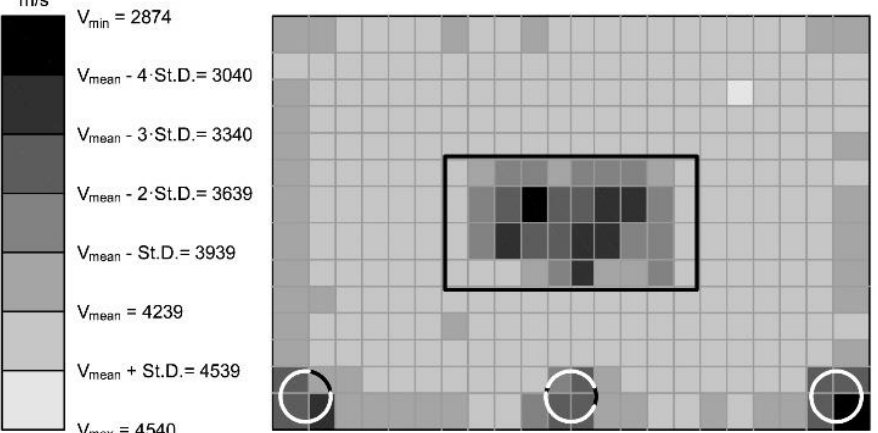
Figure 3. Map 1: Grid A. Levels of velocity.